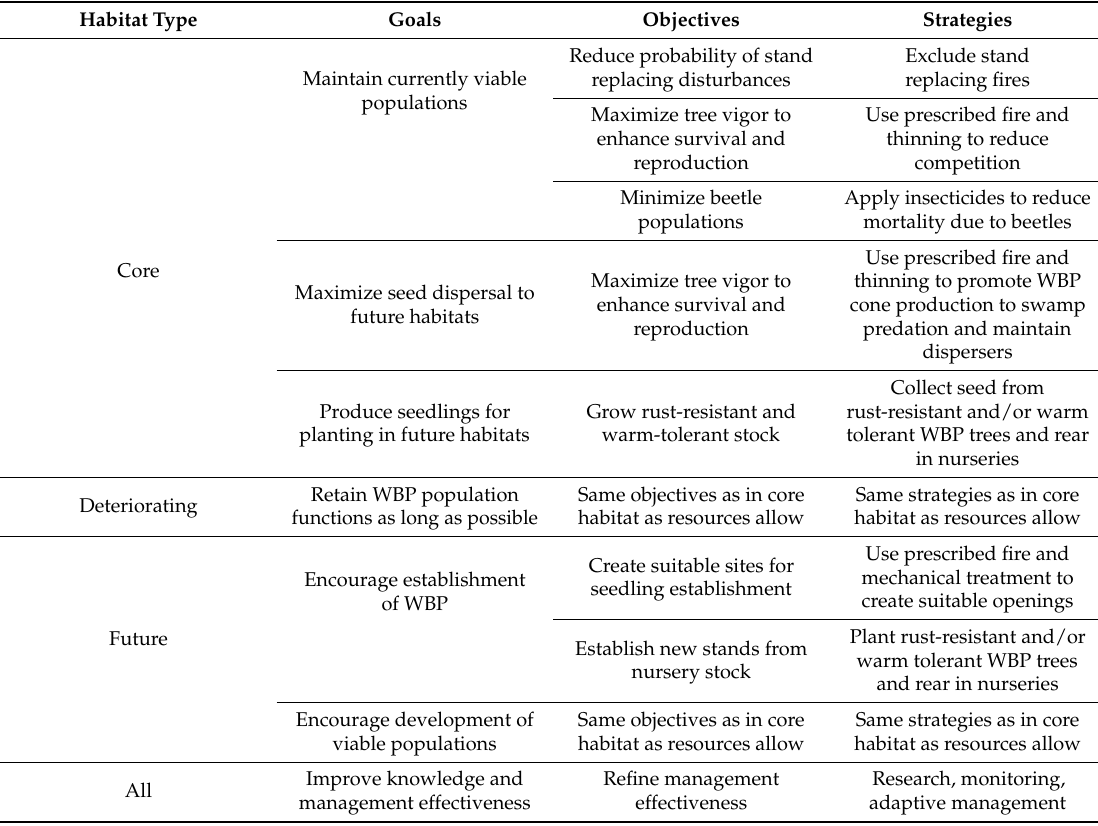
Table 4. A framework for managing WBP in the GYE based on projected future climate suitability. Habitat